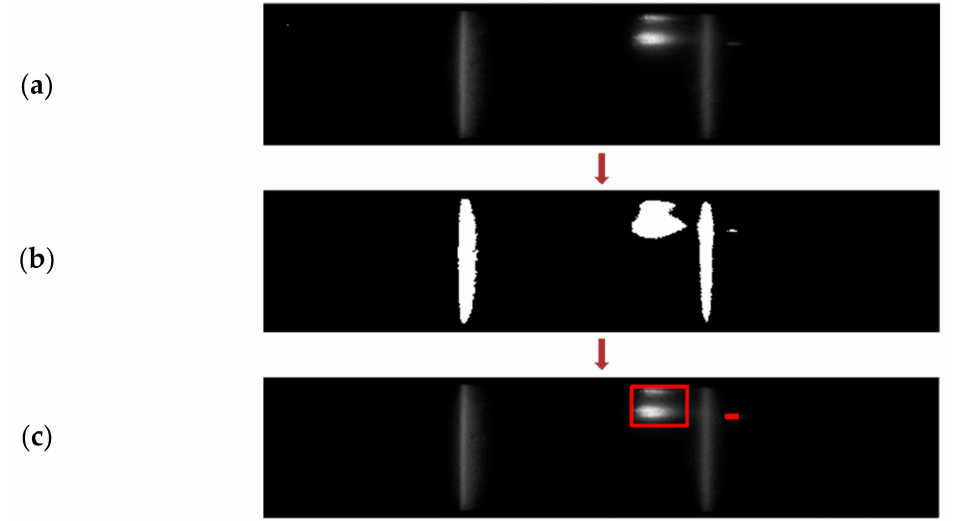
Figure 13. ( a ) Image frame captured for the detection of bright spots within NC membrane. ( b ) Corresponding binary map obtained. ( c ) Anomalies detected with the algorithm.